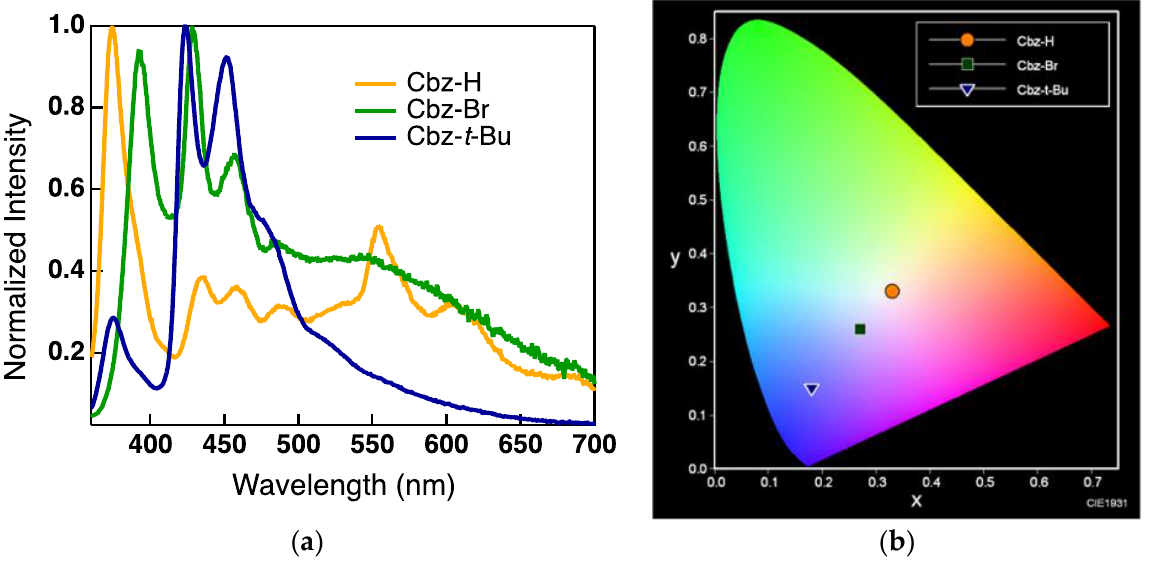
Figure 5. ( a ) Solid-state emission spectra ( λ ex = 300 nm) of complex Cbz-R (orange, Cbz-H ; green, Cbz-Br ; blue, Cbz- t- Bu ). ( b ) CIE plot for the luminescence of complex Cbz-R in the crystal state.